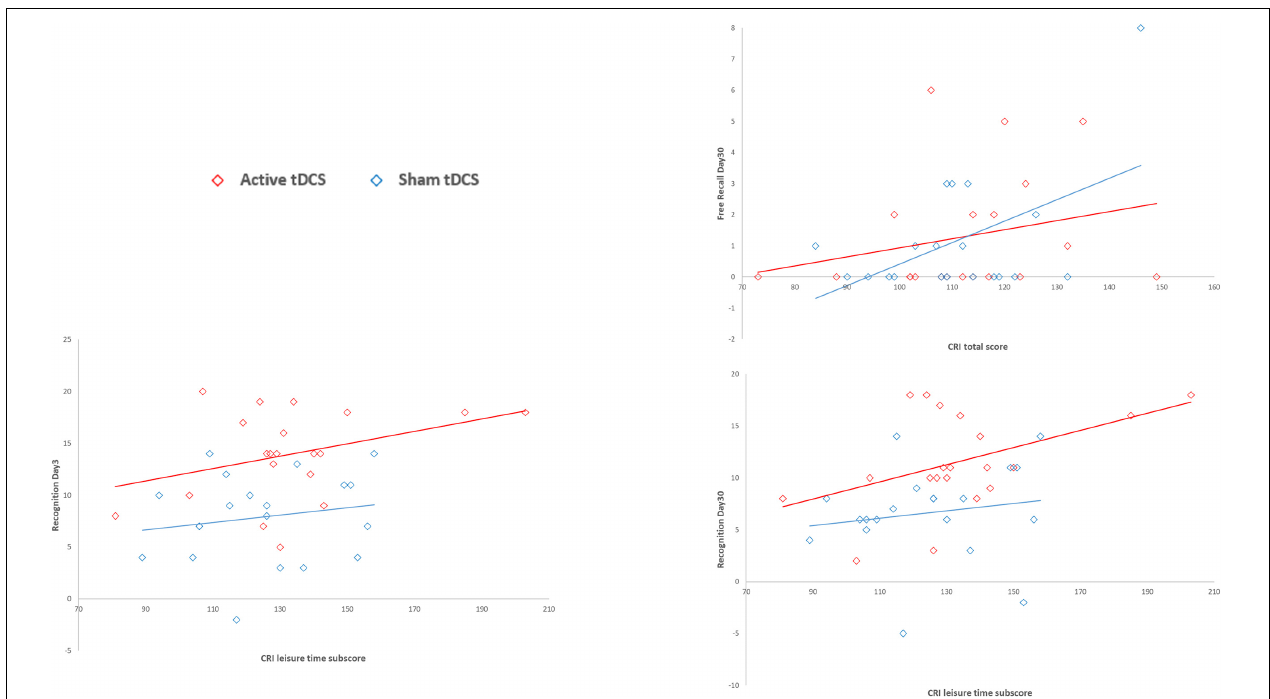
FIGURE 2 | Association between CRI scores and Free Recall and Recognition variables by tDCS group. CRI total score significantly predicted free recall performance only on Day 30, suggesting that higher cognitive reserve led to higher free recall performances only in the long-term follow up (30 days after encoding). The CRI leisure time subscore significantly predicted recognition performance both on Day 3 and on Day 30, suggesting that the higher cognitive reserve, measured as leisure time activities, led to higher recognition performances in both short- and long-term follow-ups (3 and 30 days after encoding).